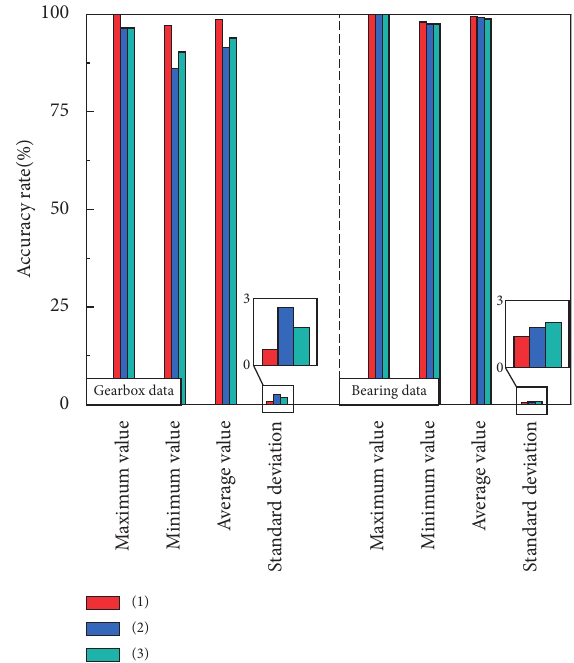
Figure 23: Verification of the necessity of UPEMD and